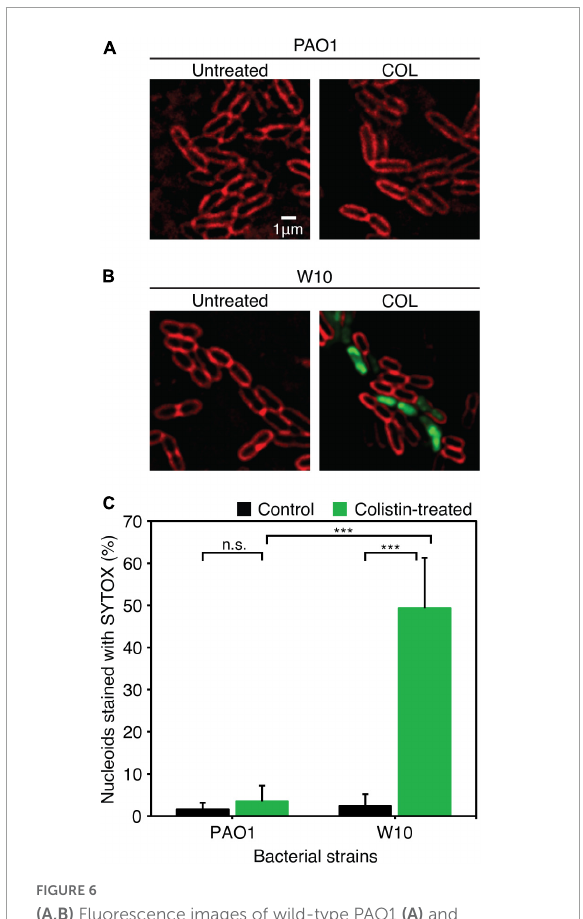
FIGURE6 (A,B) Fluorescence images of wild-type PAO1 (A) and phage-resistant isolates (W10) (B) upon treatment with COL. The cell membrane was stained with FM4-64 (red) and nucleoid of cells with impaired membrane integrity was stained with impermeable SYTOX (Green). (C) Percentage of nucleoids strained with SYTOX Green after treatment with COL in wild-type PAO1 and phage-resistant isolation (W10) compared to untreated cells. SYTOX Green was used to stain DNA as an indicator for the cells with permeabilized membranes. Asterisks represent significant differences in data at p ≤ 0.001 according to the student’s t- test and n.s. represents statistical non-significance of data. The test was performed in triplicate. Scale bar equals 1 µ